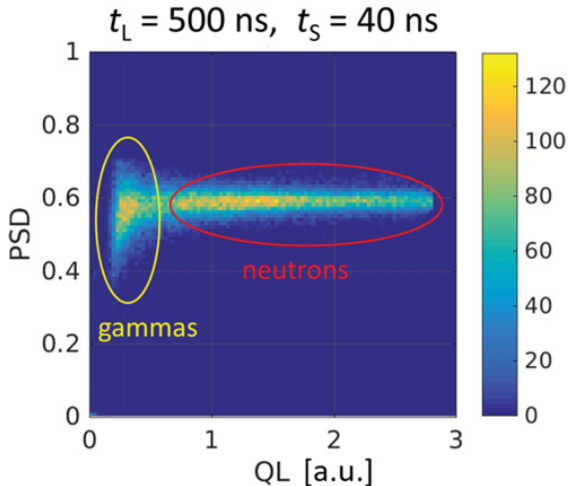
Figure 8. PSD as a function of Q L from UCN data taken on the West-1 beamport. The events are collected from the selected SiPM.The UCN events are located PSD in the region 0 . 8 < Q L < 2 . 8 and γ -rays at Q L < 0 . 5,